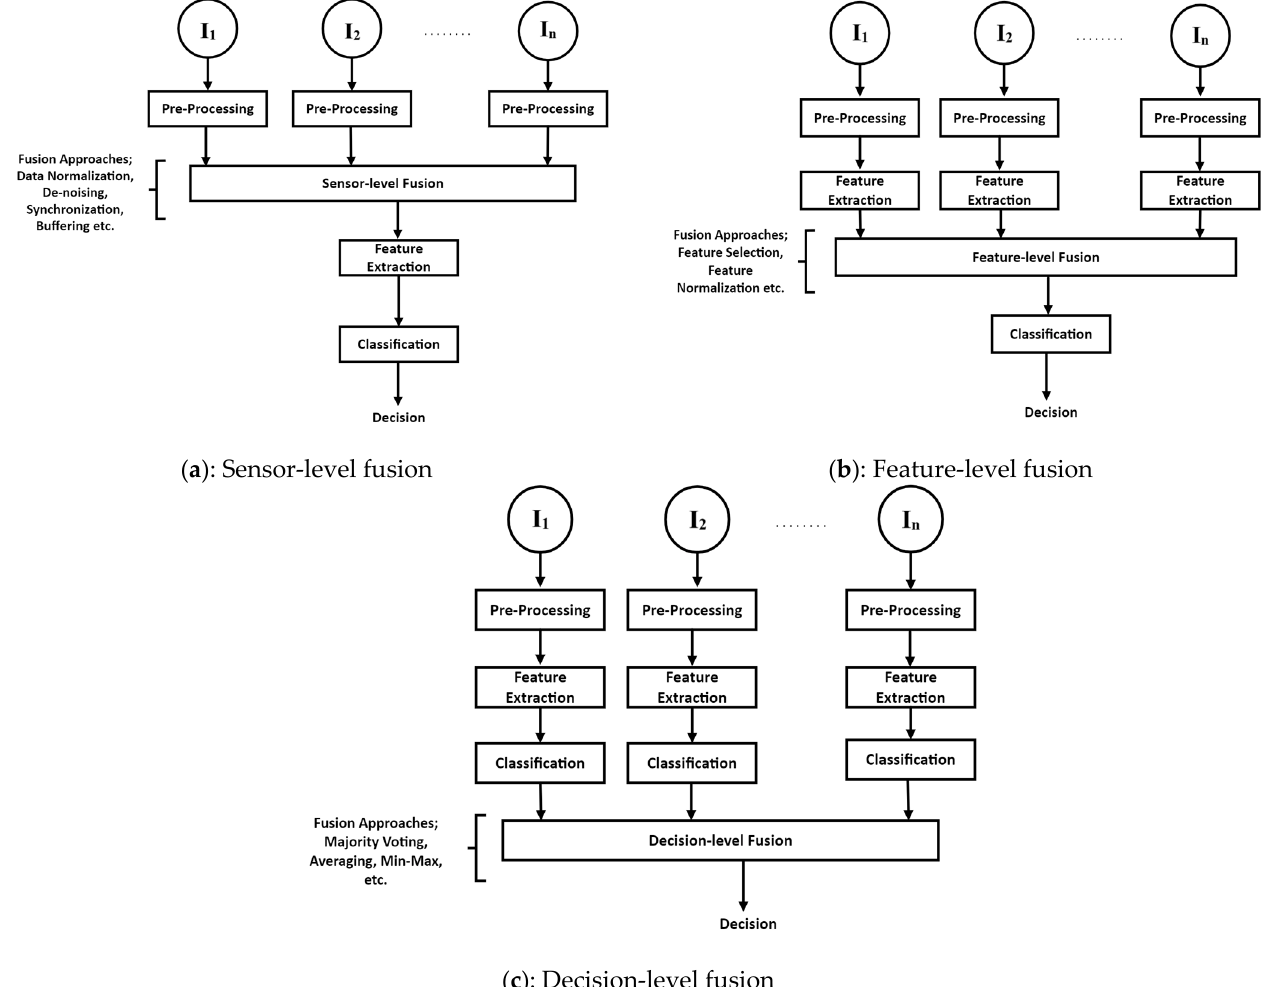
Figure 2. ( a – c ): Different types of data fusion [46–51].